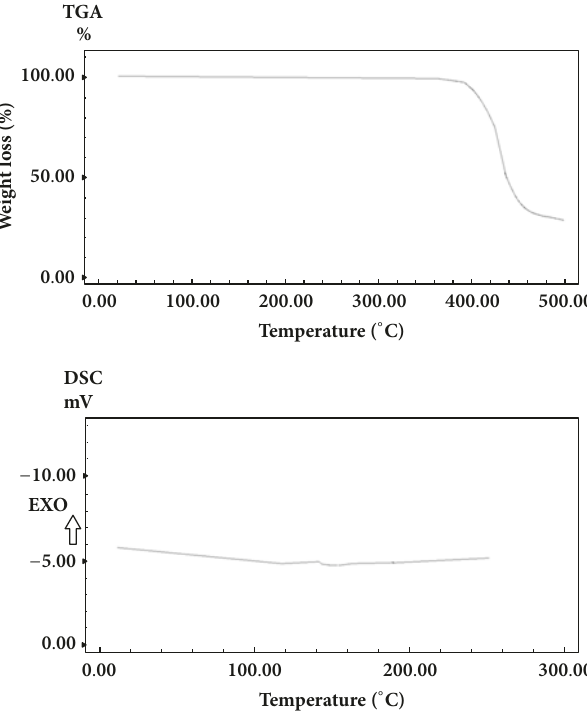
Figure 4: (a) TGA and (b) DSC curves of the poly(AN-co- VP)/zeolite